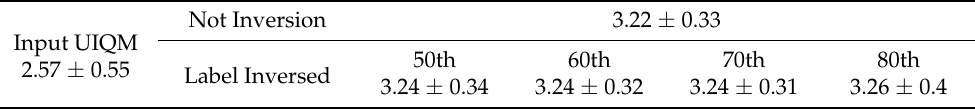
Table 5. The UIQM value comparison of a different epoch.